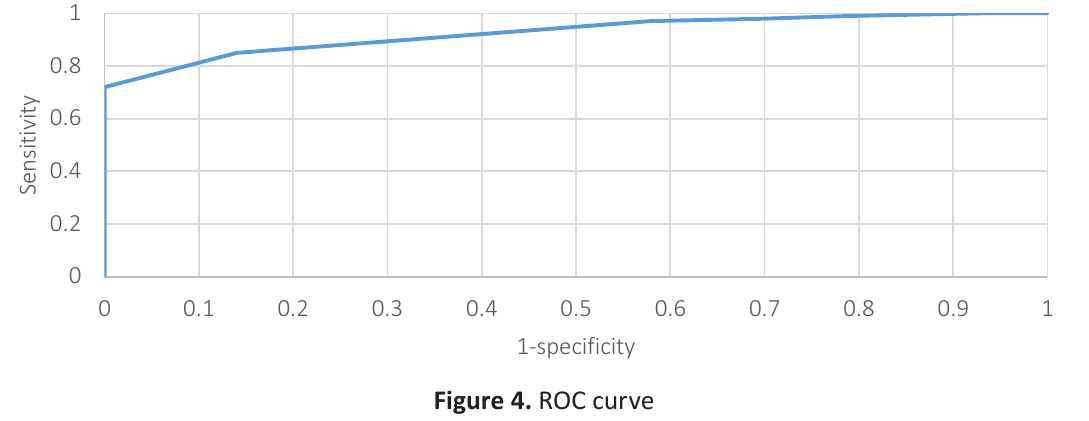
Figure 4. ROC curve